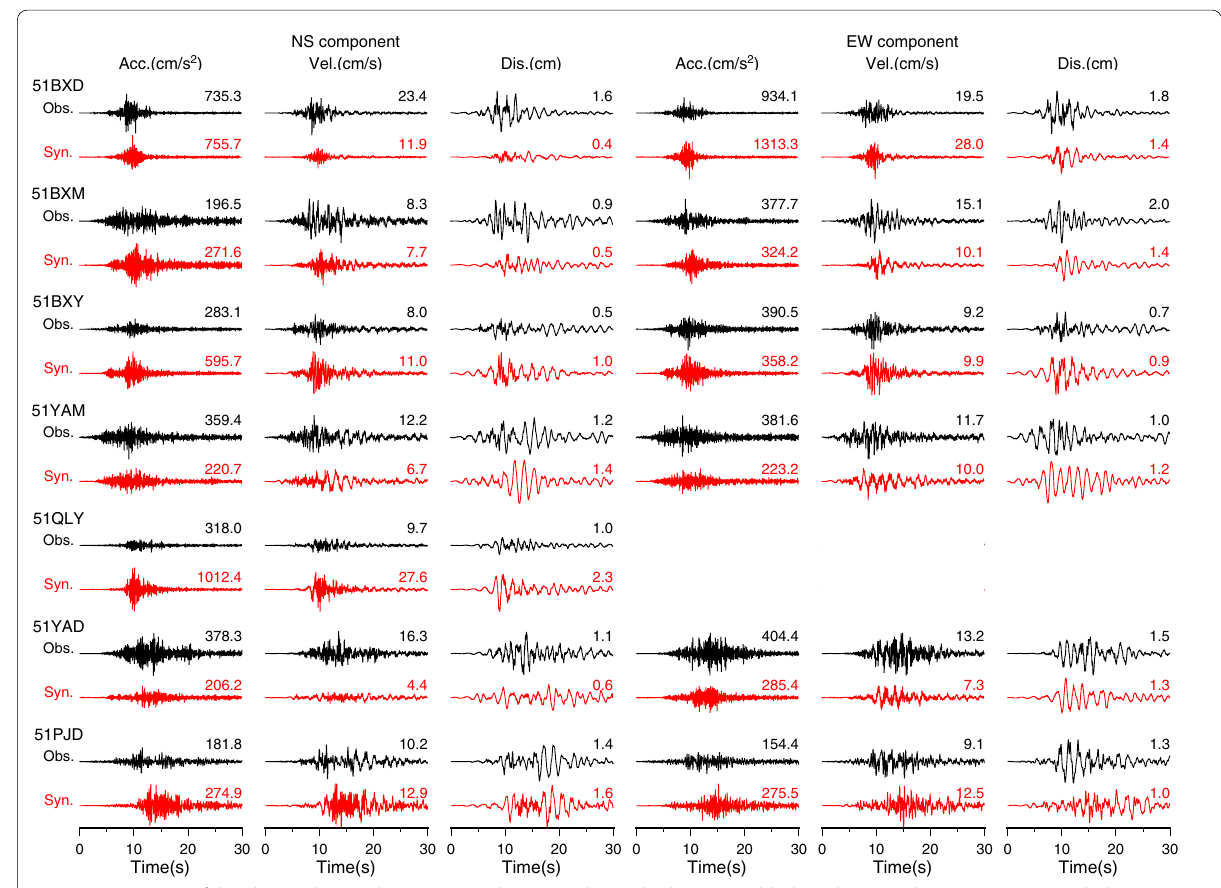
Fig. 4 Comparison of the observed ground motions (acceleration, velocity, displacement) (black) in the NS and EW components with the synthesized ground motions (red). The ground motions only in the NS component are estimated at Station